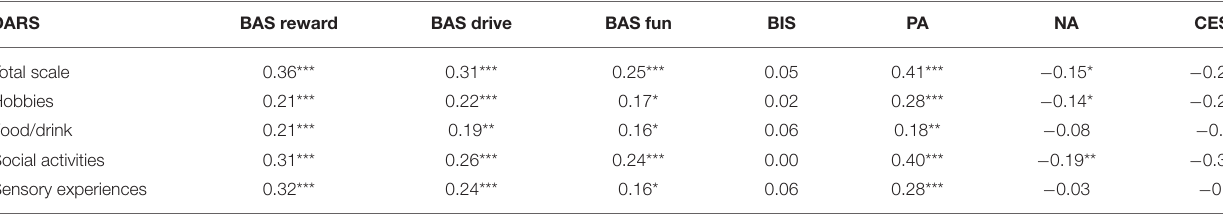
TABLE 4 | Correlations between the DARS and other related or diverging constructs. DARS